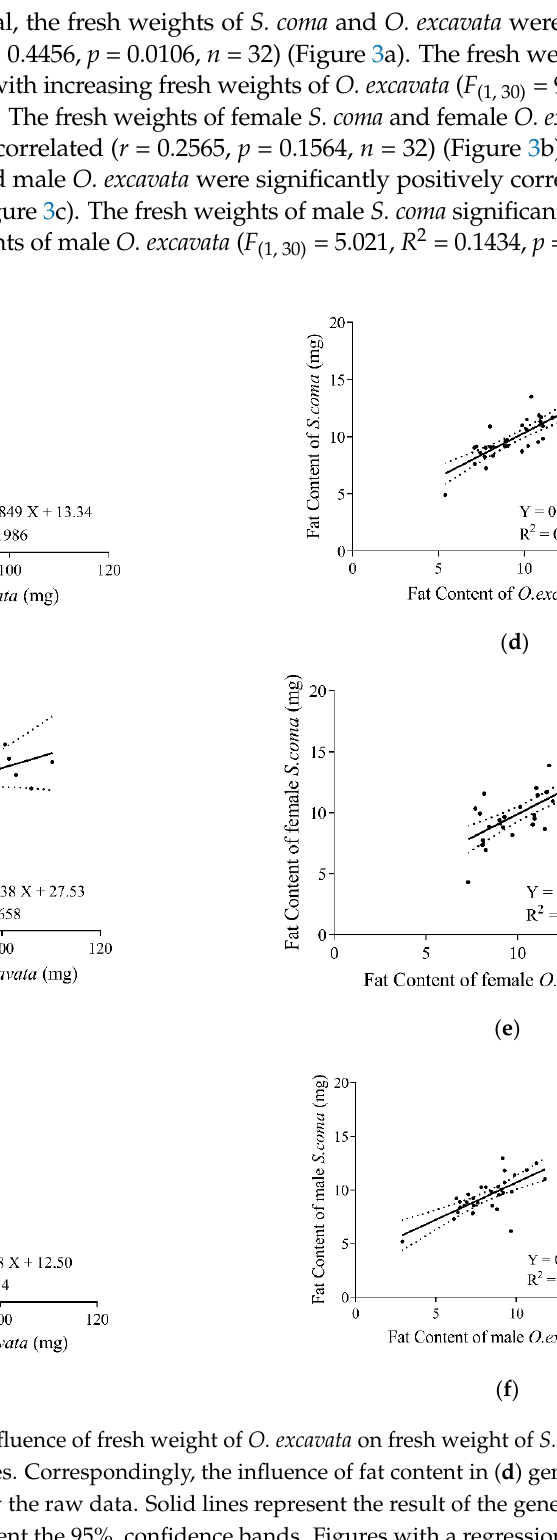
Figure 2. Influence of SCPs of O. excavata on SCPs of S. coma in ( a ) general, ( b ) females, and ( c ) males. Points show the raw data. Solid lines represent the result of the general linear model, while dashed lines represent the 95% confidence bands. Figures with a regression equation denote a significant ( p < 0.05) linear regression and without otherwise.